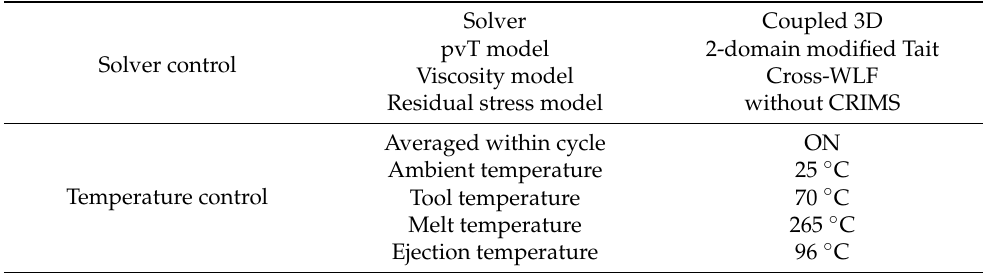
Table 3. Simulation model control